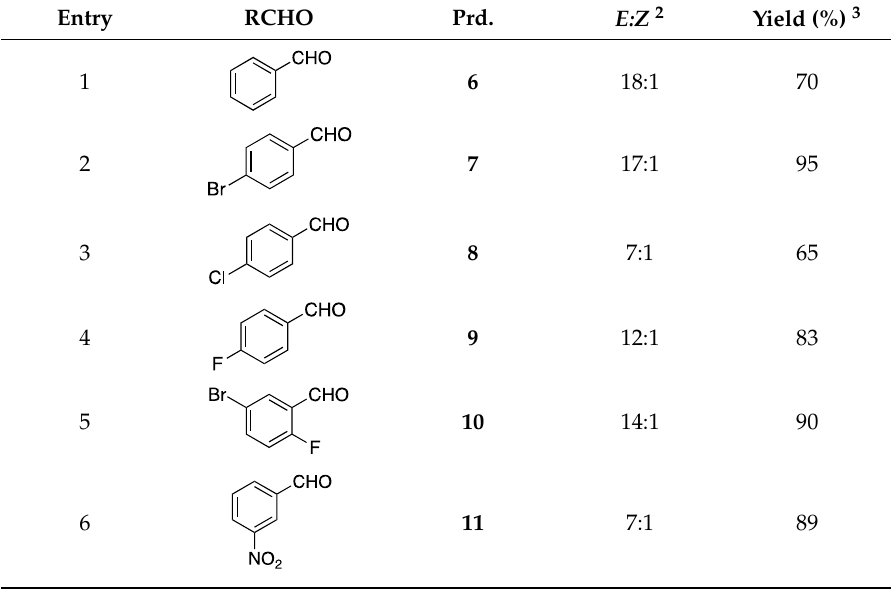
Table 1. Aldehyde scope for Wittig reactions. 1